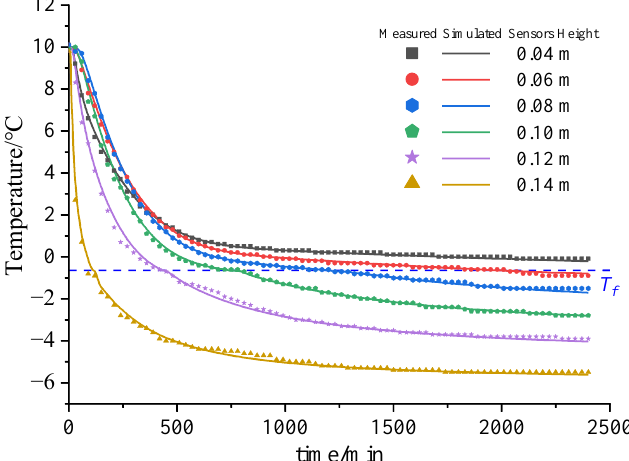
Figure 7. Temperature profiles at different heights of the sample during unidirectional freezing.